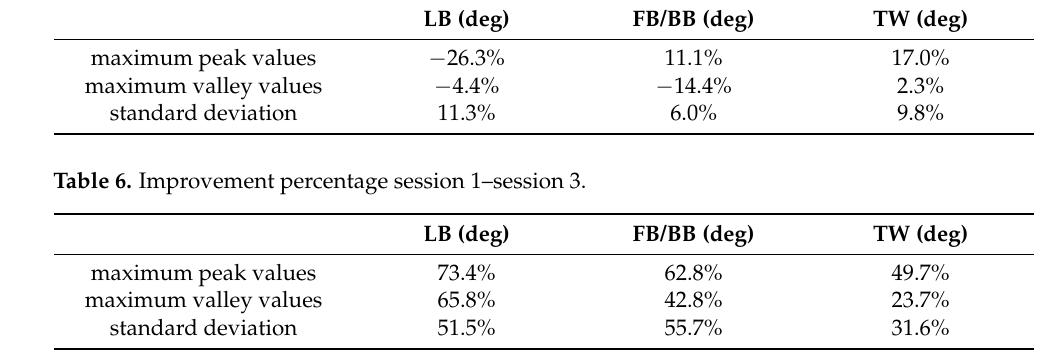
Table 5. Improvement percentage session 2–session 3.